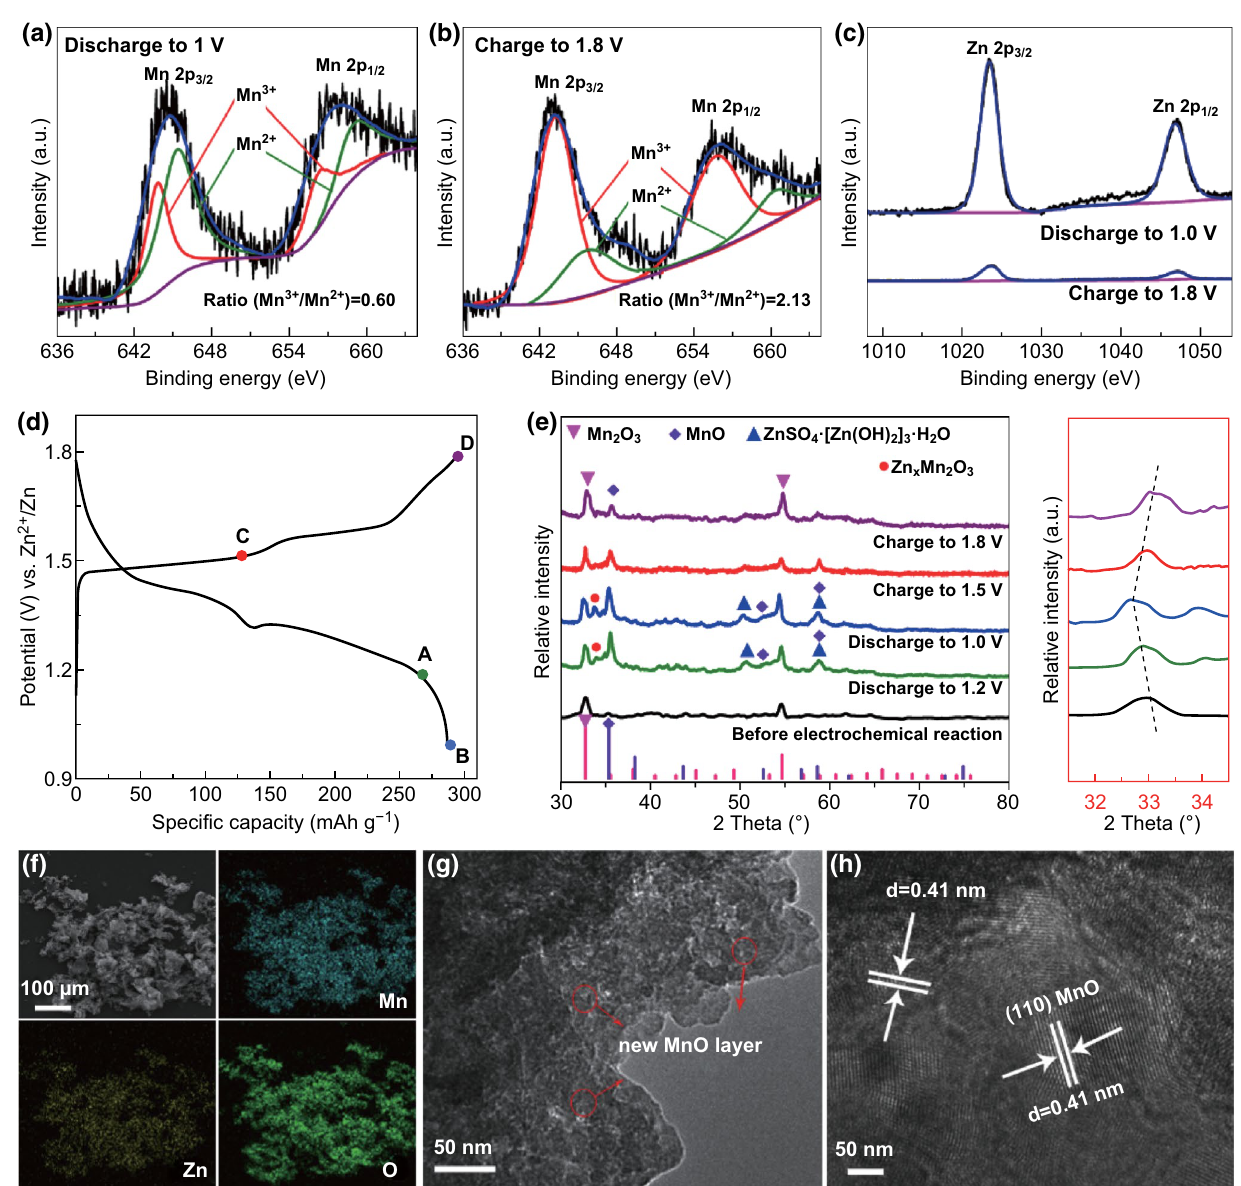
Fig. 6 Structural evolution and morphology characterization of Zn/Mn 2 O 3 batteries during the electrochemical process. High‑resolution XPS spectra of a , b Mn 2 p and c Zn 2 p at the fully discharge/charge state. d Charge/discharge profiles at 0.2C at the 100th cycle. e Ex situ XRD pat‑ terns in different discharge/charge states at the 100th cycle. f SEM–EDS mapping of the elemental distribution of Mn, Zn and O in the MMO‑ 3.2 cathode. g , h Morphology characterization of cathode materials in the fully discharge